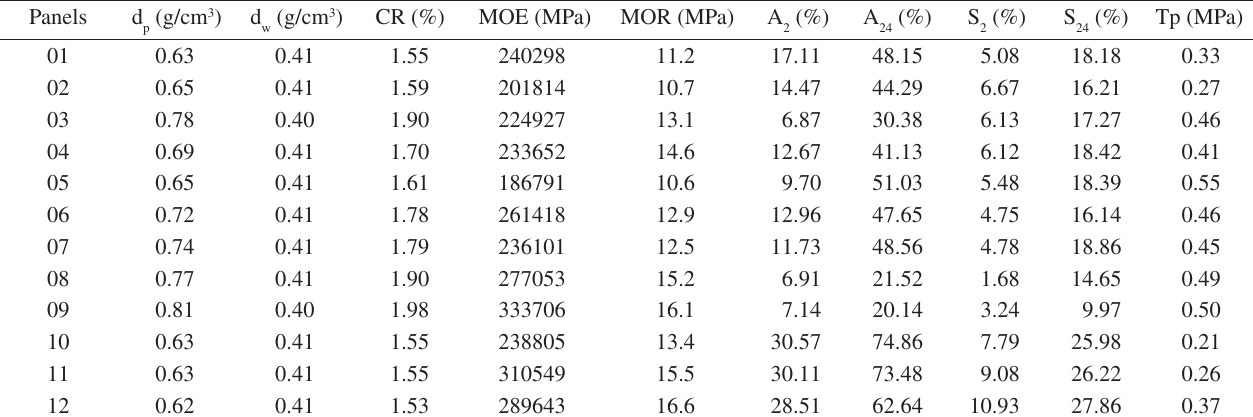
Table 2. Average values of the physical and mechanical properties of the particleboards. Panels